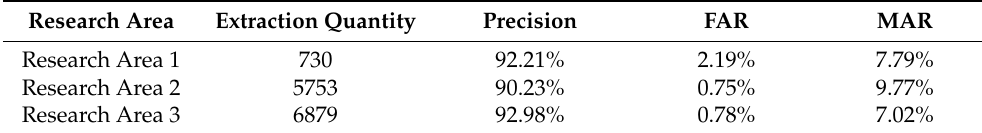
Table 2. Accuracy evaluation results of three different experimental